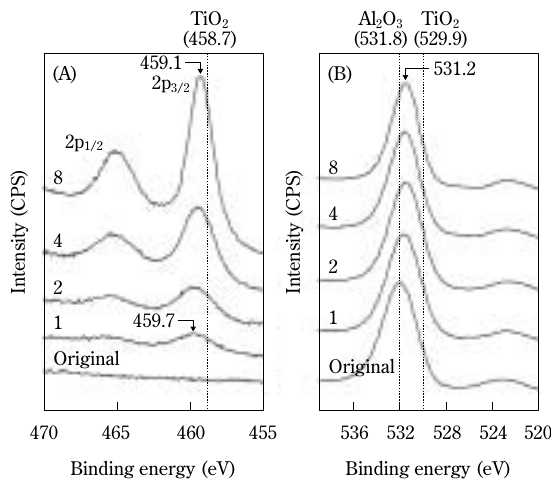
Fig. 3 TEM micrograghs of samples: (A) original alumina and (B) modified alumina (Repeat